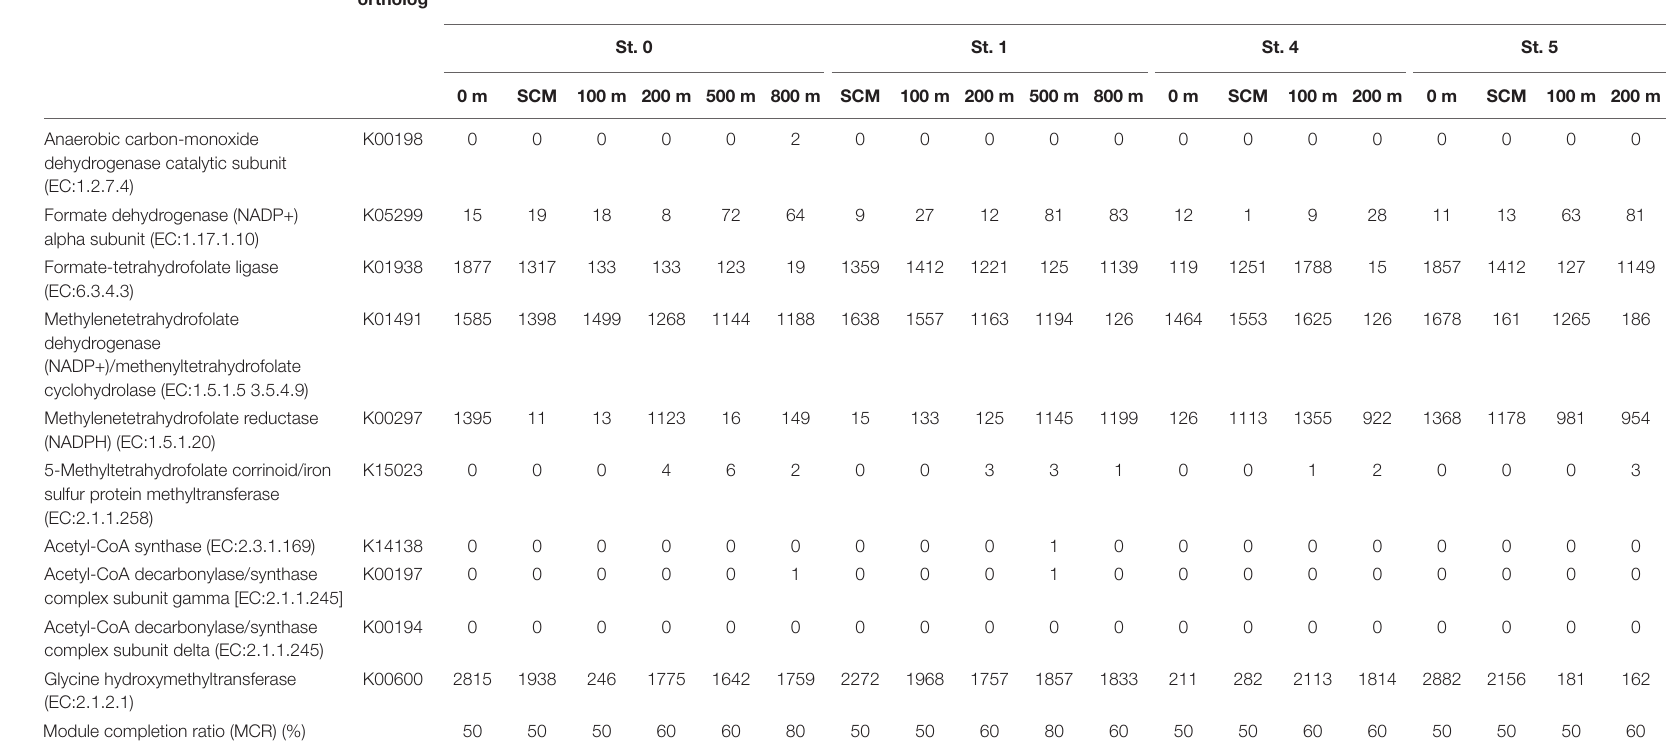
TABLE 2 | Abundance of Kyoto Encyclopedia of Genes and Genomes orthologous genes involved in the acetyl-CoA pathway (analyzed by the MAPLE software with three million predicted gene sequences from each sample). Definition KEGG Abundance of KEGG orthologous genes within 3 million predicted gene sequences ortholog St. 0 St.